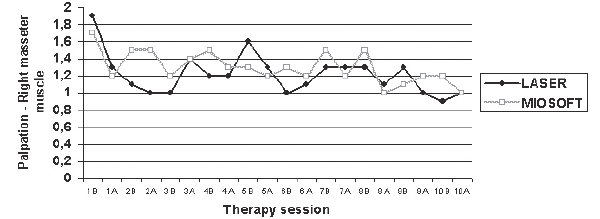
FIGURE 5- Mean of palpation figures of the right masseter muscle, before and after each therapy session